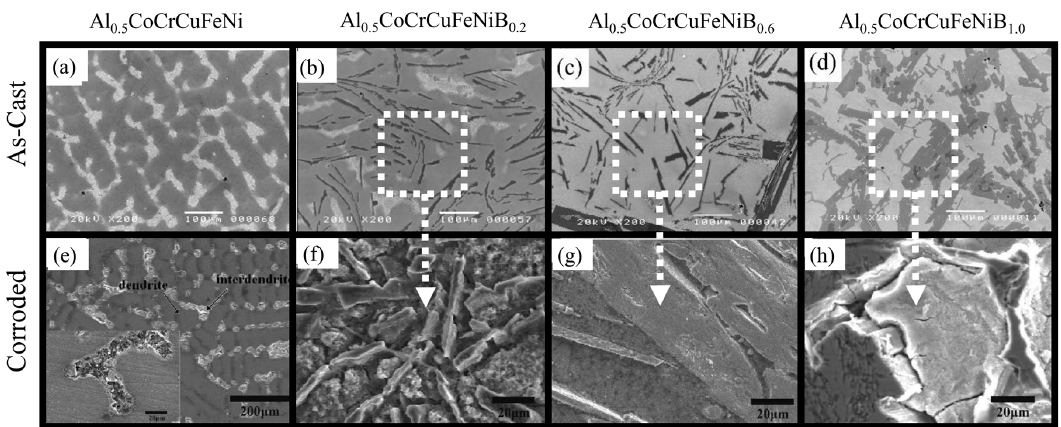
Figure 10. Microstructure of the as-cast alloys with increasing Boron content: ( a ) boron free alloy; ( b ) Boron = 0.2; ( c ) Boron = 0.6; and ( d ) Boron = 1.0. Corroded features on respective microstructures. Preferred corrosion of ( e ) inter-dendritic phase ( f ) of stringer features ( g ) and ( h ) borides [38,39] (reprinted with permission Journal of the Electrochemical Society and Springer).